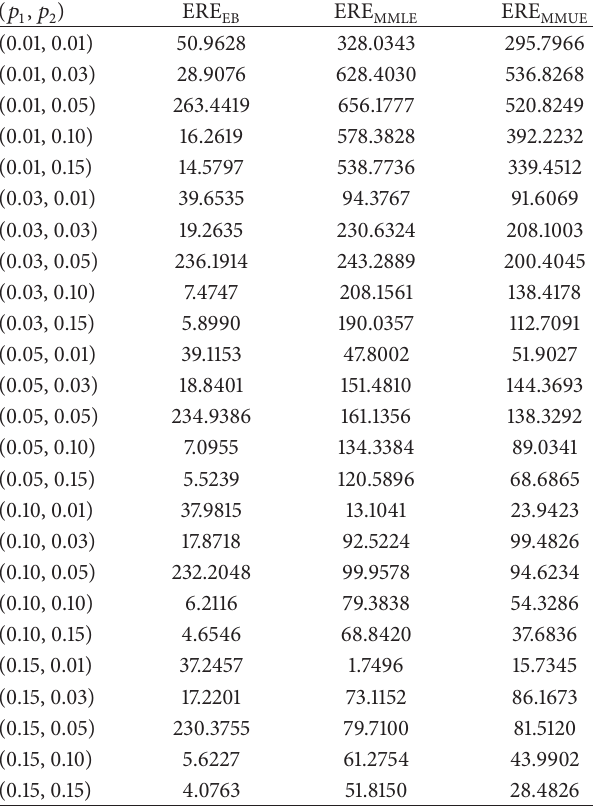
Table 6: The percentages of the Estimated Relative Error of odds ratio estimation for (𝑛 1 , 𝑛 2 ) = (10,50).